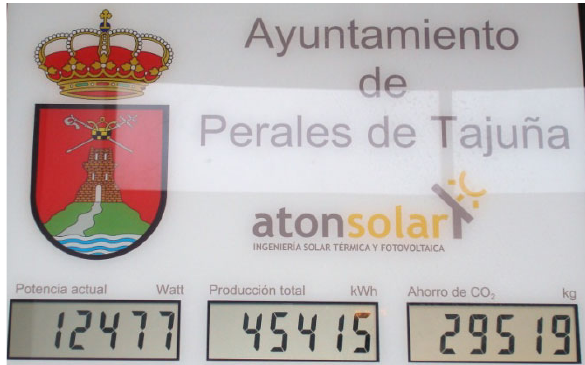
Figure 1. Information panel at a sport centre in a village of Spain, showing the CO 2 emissions (29519 kg CO 2 ) avoided by using solar